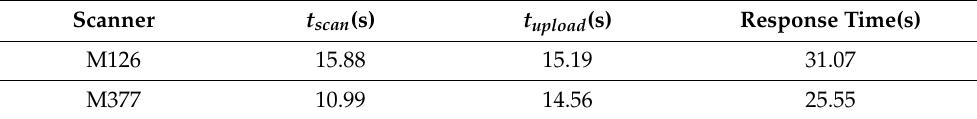
Table 2. The response time of the counterfeit